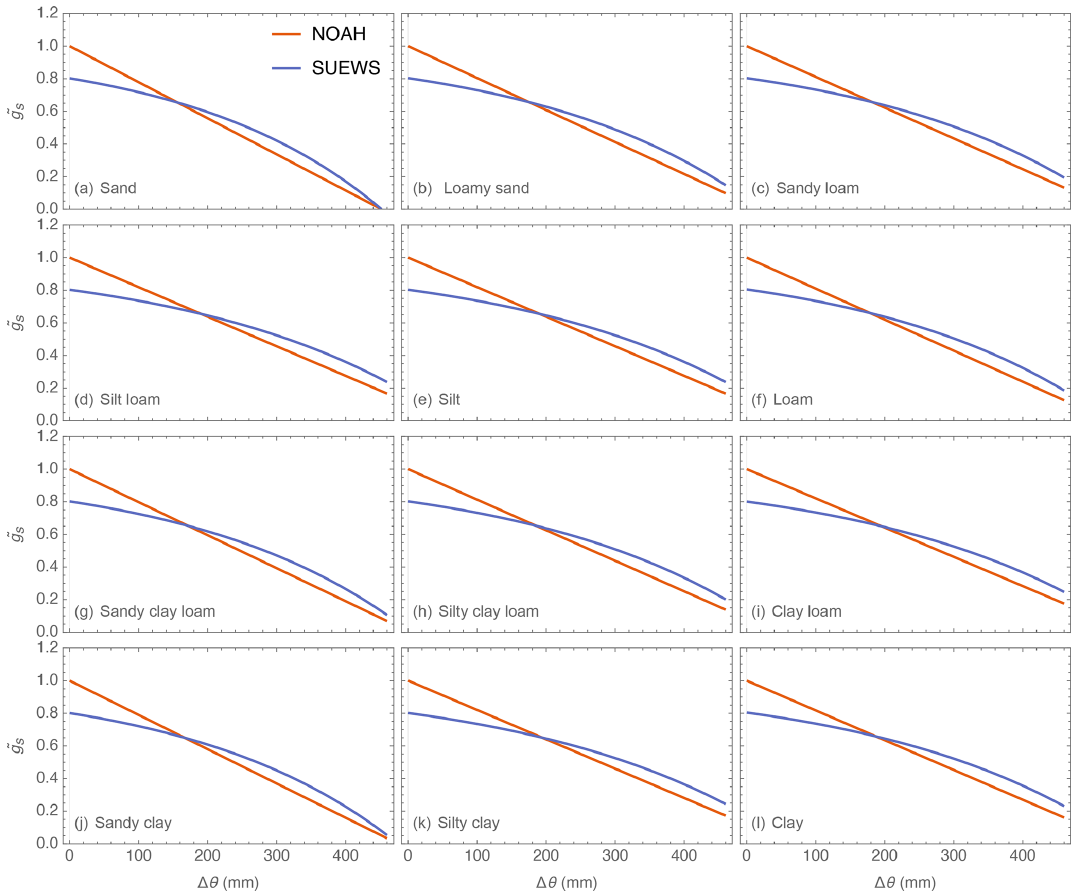
Figure A2. As Fig. A1 but for soil moisture deficit ( (cid:49)θ ) for different soil types with an assumed soil depth of 2000mm. Soil hydraulic properties (field capacity θ FC and wilting point θ WP ) are provided in Table